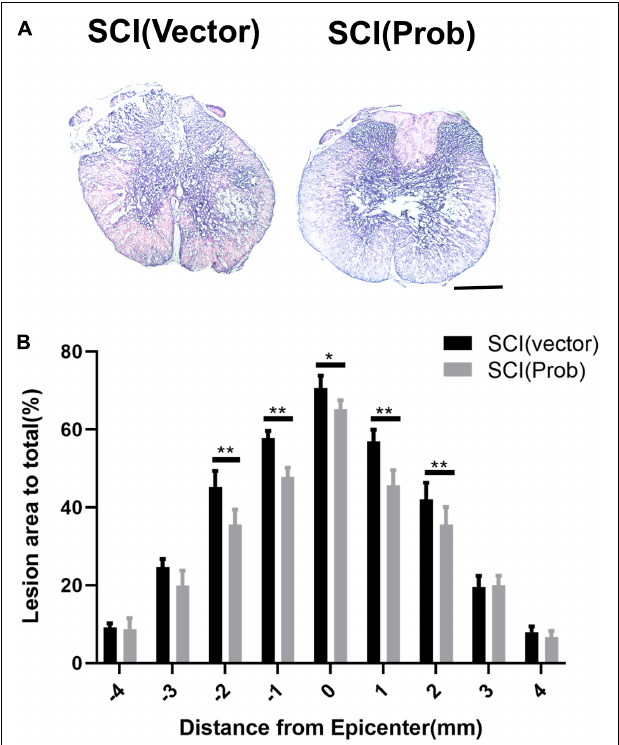
FIGURE 6 | Quantitative analysis of the effect of Probenecid on myelin preservation. (A) Representative pictures of LFB staining in the transverse sections of 2 mm rostral to the epicenter of spinal cords. (B) Quantitative analysis of residual myelination in different groups at different distances from the epicenter (0 mm) and 1, 2, 3, and 4 mm rostral (+) and caudal (–) from the epicenter (* p < 0.05, ** p < 0.01 n = 6). Scale bar: 500 µ